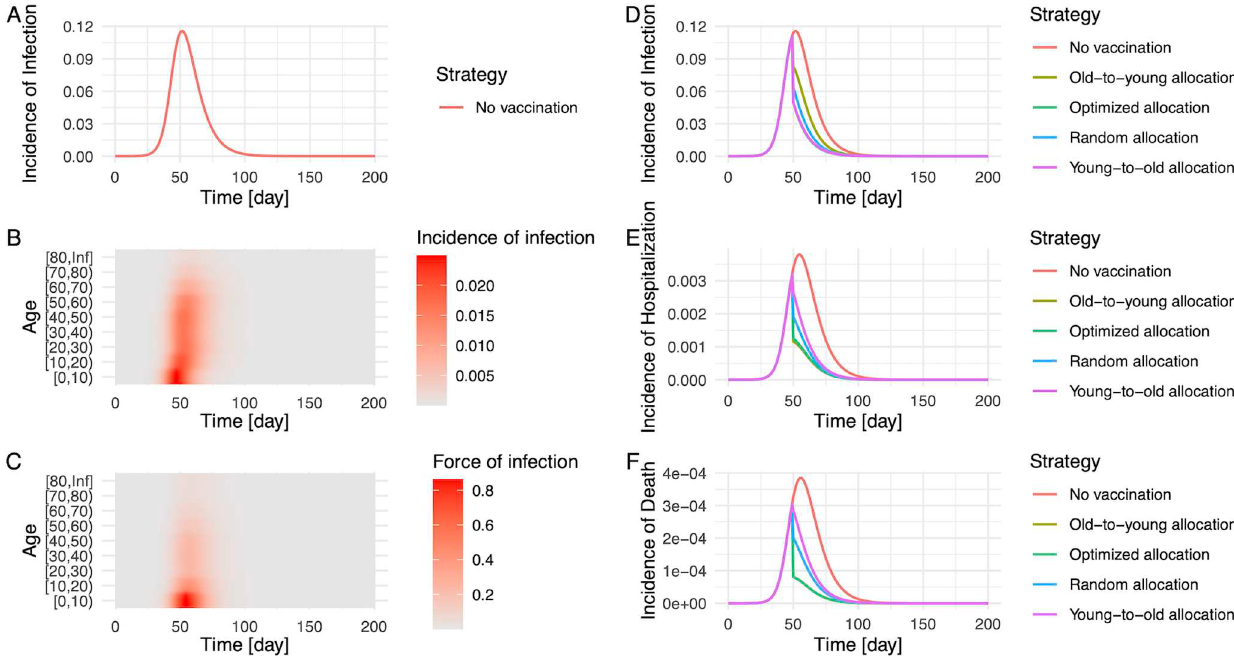
Fig 1. Simulated epidemic and evaluation of the impact of vaccination by allocation strategy. The epidemic is simulated by an age-structured SIR model. R 0 and generation time were set as 1.2 and 5 days, respectively. The population was stratified by 10-year age bin, and a contact matrix of the Netherlands in June 2020 was used for the simulation [32]. Panel (A) illustrates the total incidence of infection in the population, and age-specific incidences (B) and the force of infection (C) reflect heterogeneous contacts between age-groups. The impact of vaccination on the number of infections (D) , hospitalizations (E) , and deaths (F) was compared under five different strategies; no vaccination (red), allocation from old to young groups (yellow), young to old groups (purple), at random (blue), and optimized allocation (green). In panel (D) , curves of the optimized allocation and the young-to-old allocation are overlapped. In panel (E) and (F) , curves of the optimized allocation and the old-to-young allocation are overlapped. For simplicity, the vaccination coverage was set as 40%, and the effect of vaccines was in place at day 50 (from the initial time point of the simulation), resulting in the immediate depletion of susceptible and infected individuals on that day.